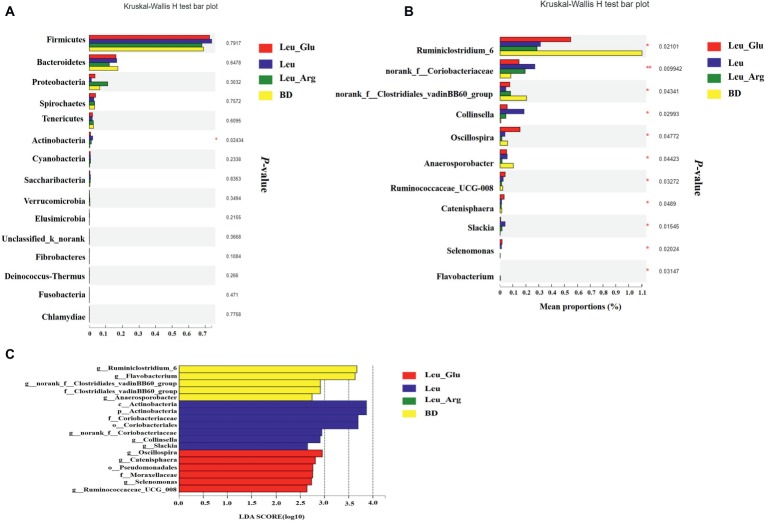
Taxonomic differences of colonic microbiota among the four groups. Comparison of relative abundance at the phylum (A) and genus (B) levels between the four groups. In genes levels, only data of which differences with p less than 0.05 are shown. All the differences were analyzed using Mann-Whitney U test; ∗p < 0.05; ∗∗p < 0.01. (C) Linear discriminant analysis (LDA) scores for the enriched microbiota.